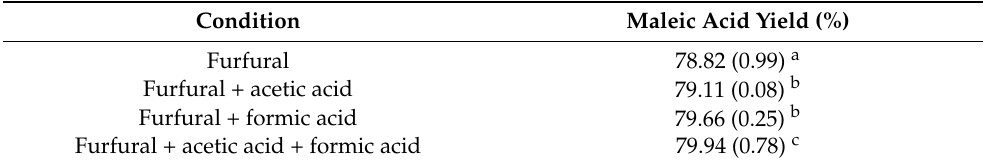
Table 4. Maleic acid production from the synthetic medium using formic acid (4 mL) and H 2 O 2 (1 mL).